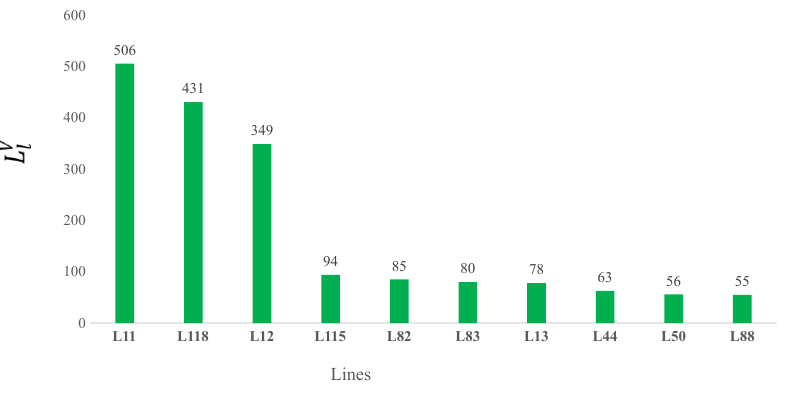
Figure 5. L V : The average number of times that line l is overloaded, given a k single l